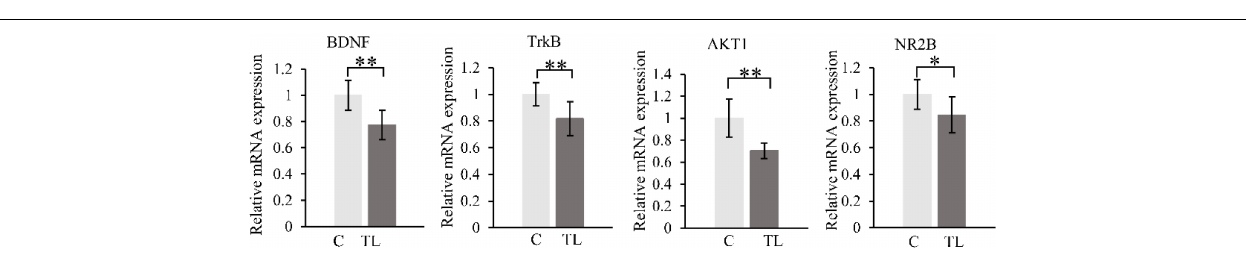
FIGURE 5 | RT-PCR results. BDNF (A) , TrkB (B) , AKT1 (C) , and NR2B (D) . The data are expressed as the mean ± SD, ∗ indicates that there is a statistical difference between the two groups ( t -test, ∗ P < 0.05, ∗∗ P <